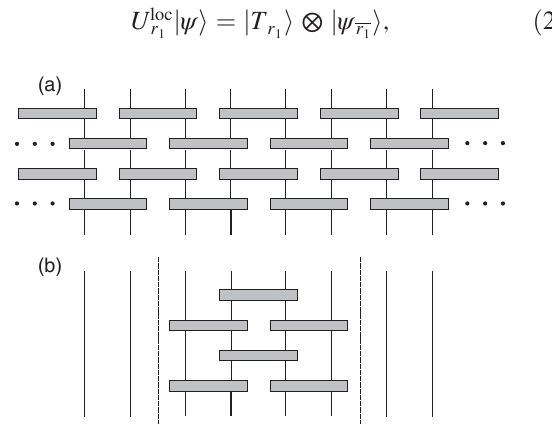
FIG. 1. Three-dimensional system with periodic boundary conditions and Z P 2 reflection symmetry. Each point on the solid FIG. 2. (a) One-dimensional local unitary represented as a circle corresponds to a 2D plane with periodic boundary con- finite-depth quantum circuit. The vertical lines represent spins, ditions. The dashed line intersects the system at the two mirror and each shaded rectangle is a unitary operator acting on a pair of planes o and ∞ , which are contained in the shaded regions r o and spins. (b) Restriction of a 1D local unitary to the region between r w . Dotted lines the two dashed lines. The two-spin unitary operators lying ∞ , respectively. These regions have thickness outside this region are simply omitted. The restriction procedure indicate the boundaries of these regions with two other regions, r 1 is not uniquely defined near the boundaries of the region, but this and σ r 1 . The regions are chosen so that r o and r ∞ are invariant freedom does not play a role in our under reflection, while r 1 and σ r 1 are exchanged under reflection.